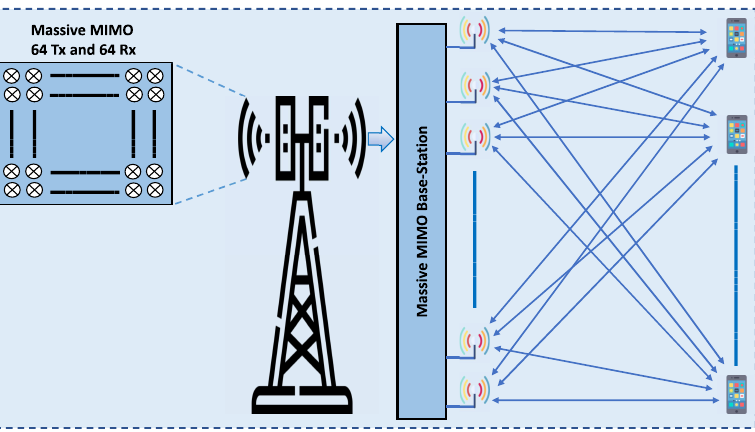
Figure 5. 5G massive MIMO